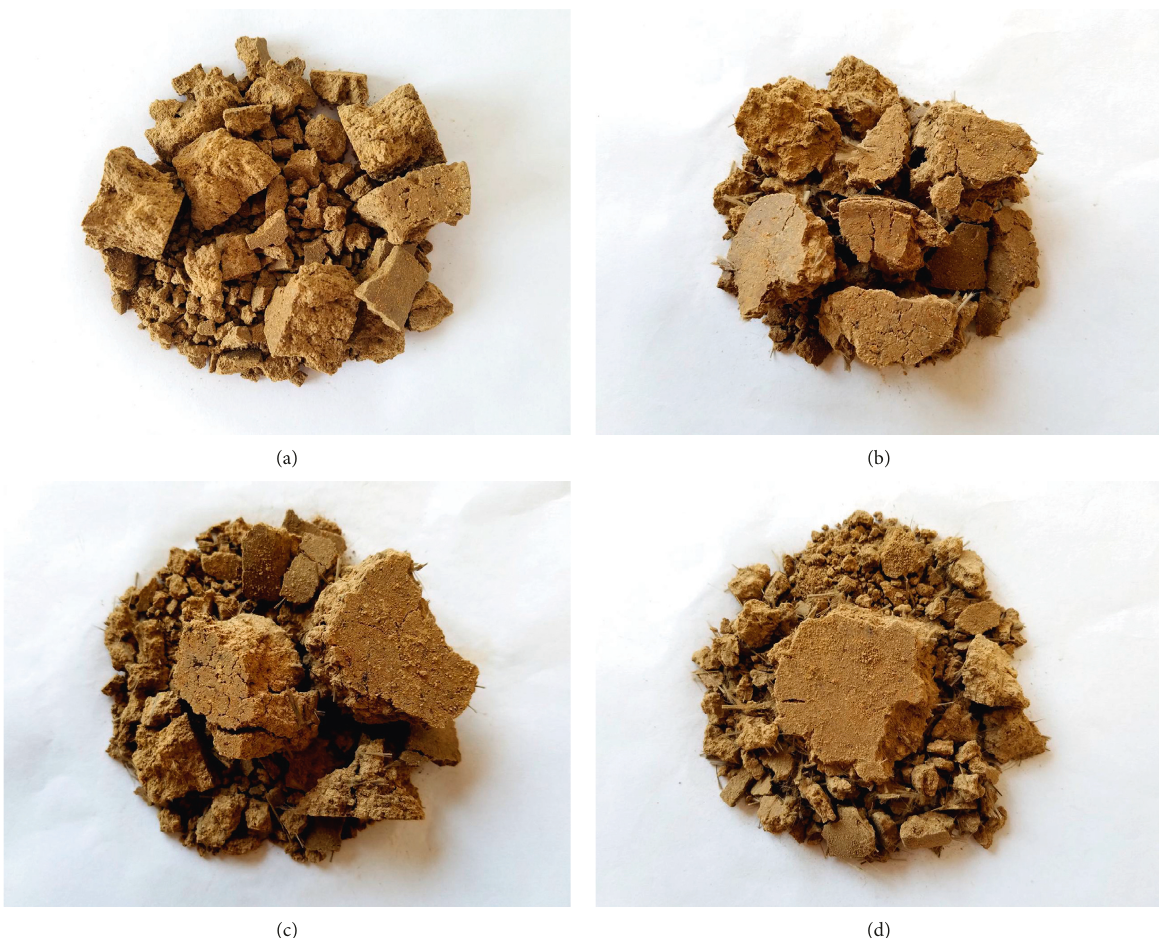
Figure 7: Failure patterns of polypropylene fiber-reinforced cement soil in SHPB tests. (a) C (d) C PP � 1.2%.